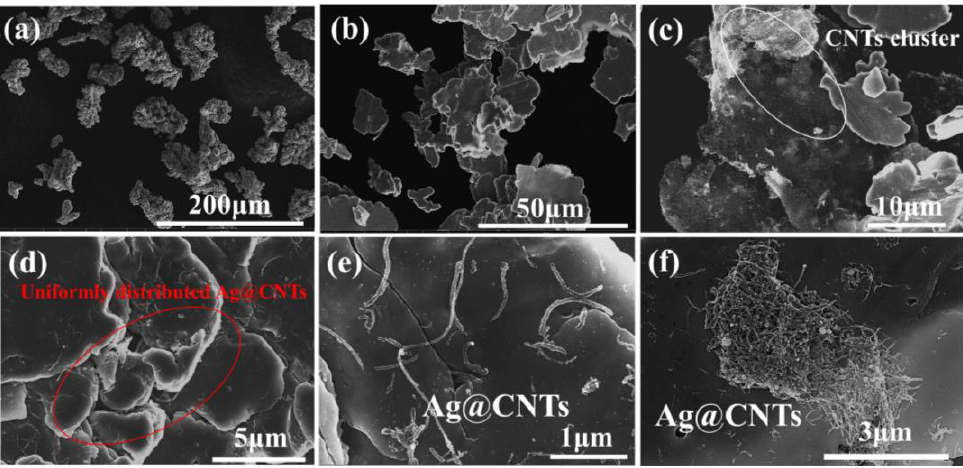
Figure 5. SEM images of powders: ( a ) pristine Cu powders; ( b ) flake Cu powders (after 10 h ball milling); ( c ) CNTs/Cu powders; ( d , e ) 0.9 vol.% Ag-CNTs/Cu powders; ( f ) 1.3 vol.% Ag-CNTs/Cu powders.